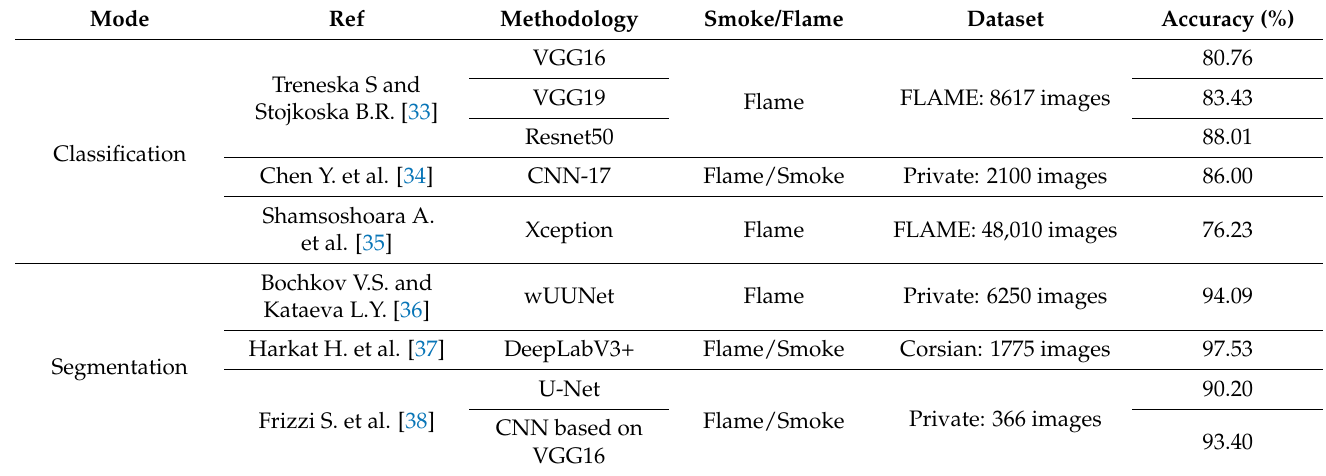
Table 7. Comparison between fire classification and segmentation